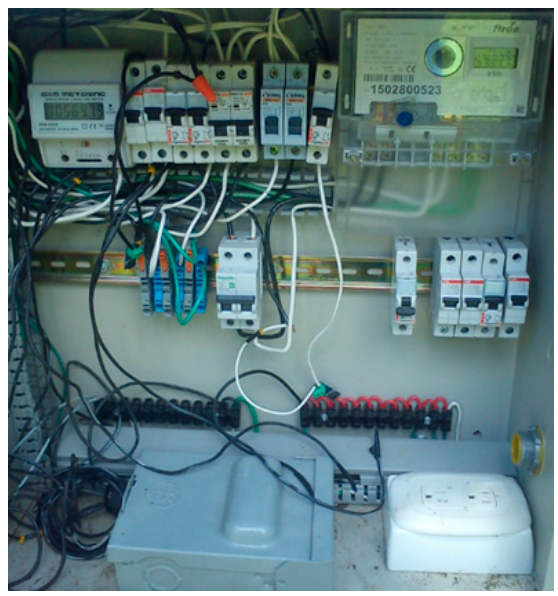
Figure 4. Point of common coupling.